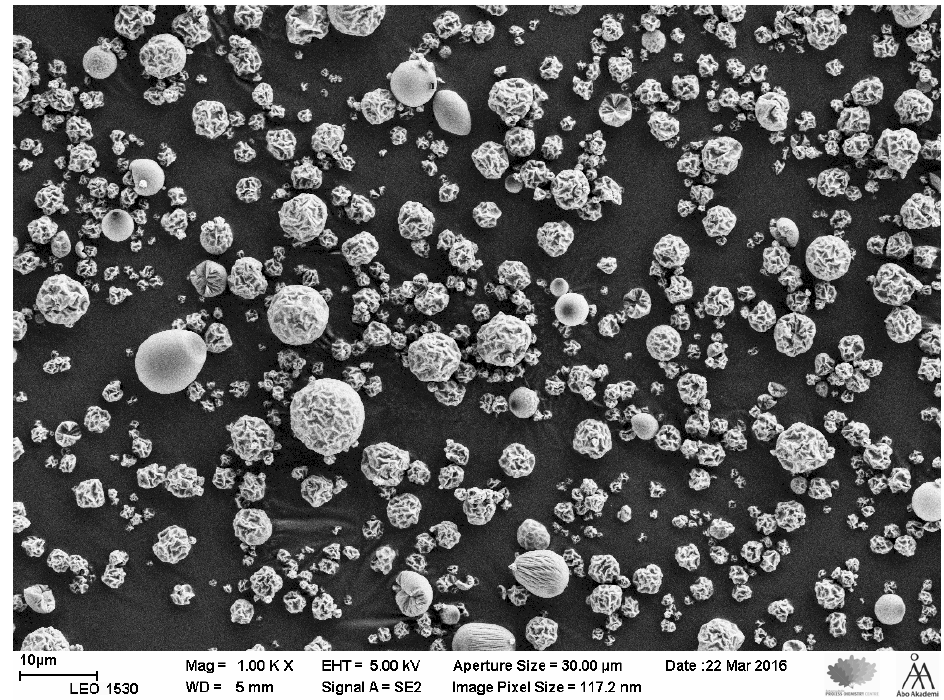
Figure 1. SEM images of pramlintide loaded silica microparticles. Magnification ×